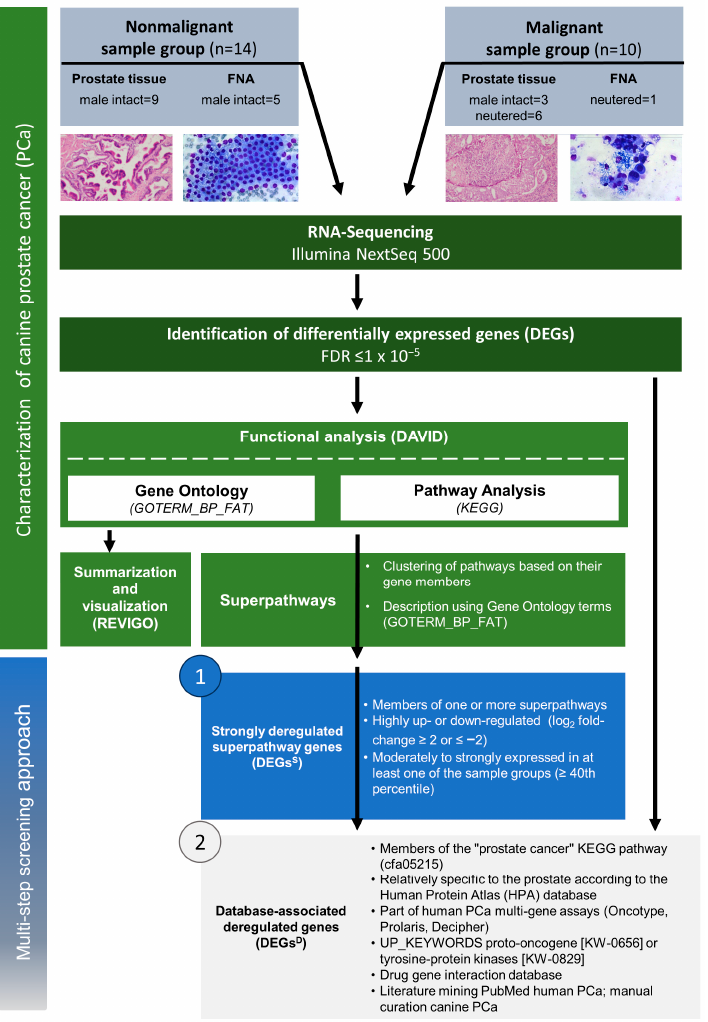
Figure 1. Experimental design. Flowchart of RNA-Sequencing (RNA-Seq) analysis for characterization (green) and identification of differentially expressed genes (DEGs) between malignant and nonmalignant canine prostate samples. Selection (blue and gray) of strongly deregulated superpathway genes (DEGs S ) and database-associated deregulated genes (DEGs D ).